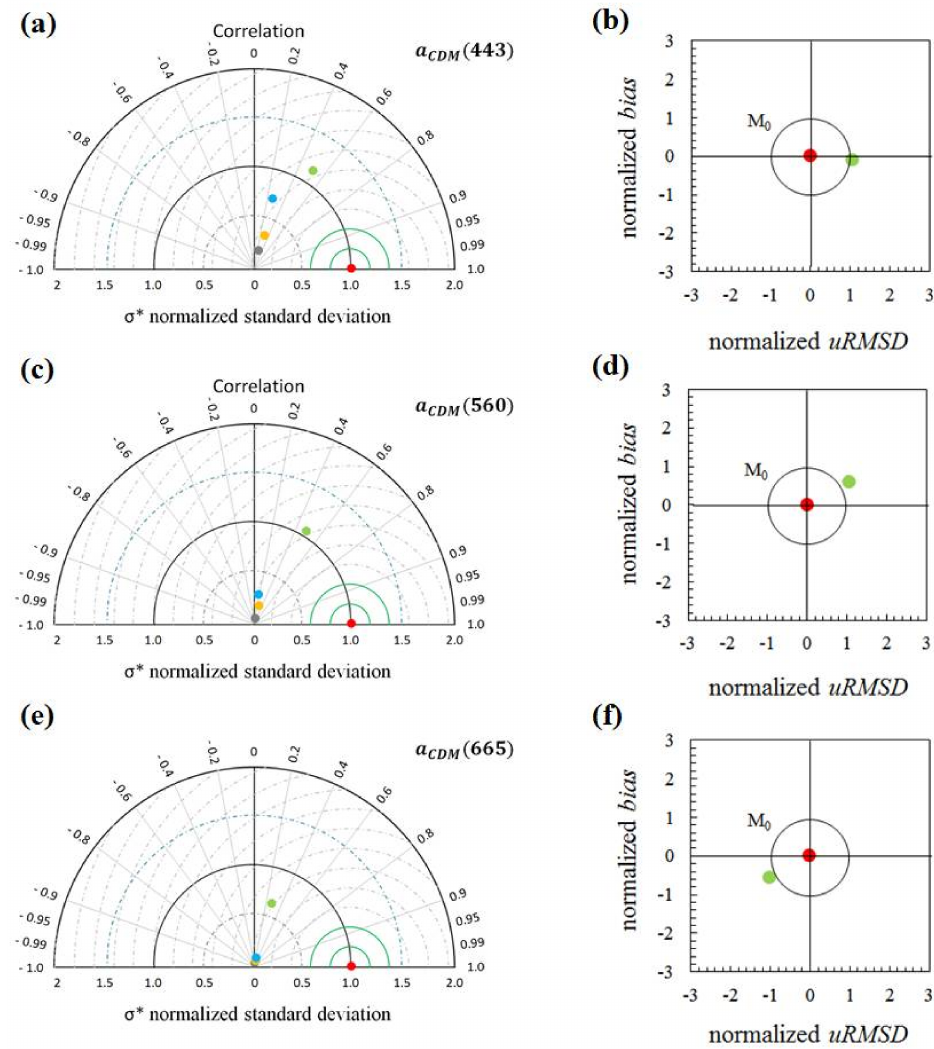
Figure 5. Taylor diagrams for a CDM ( λ ) at ( a ) 443 nm, ( c ) 560 nm, and ( e ) 665 nm. Target diagrams for a CDM ( λ ) at ( b ) 443 nm, ( d ) 560 nm, and ( f ) 665 nm. Symbols indicate the following: QAA Lv5 (gray dot), QAA Lv6 (yellow dot), QAA M14 (blue dot), QAA OMW (green dot), and the reference observation (red dot). The black circle in the Target diagrams (M 0 ) corresponds to a normalized total RMSD of